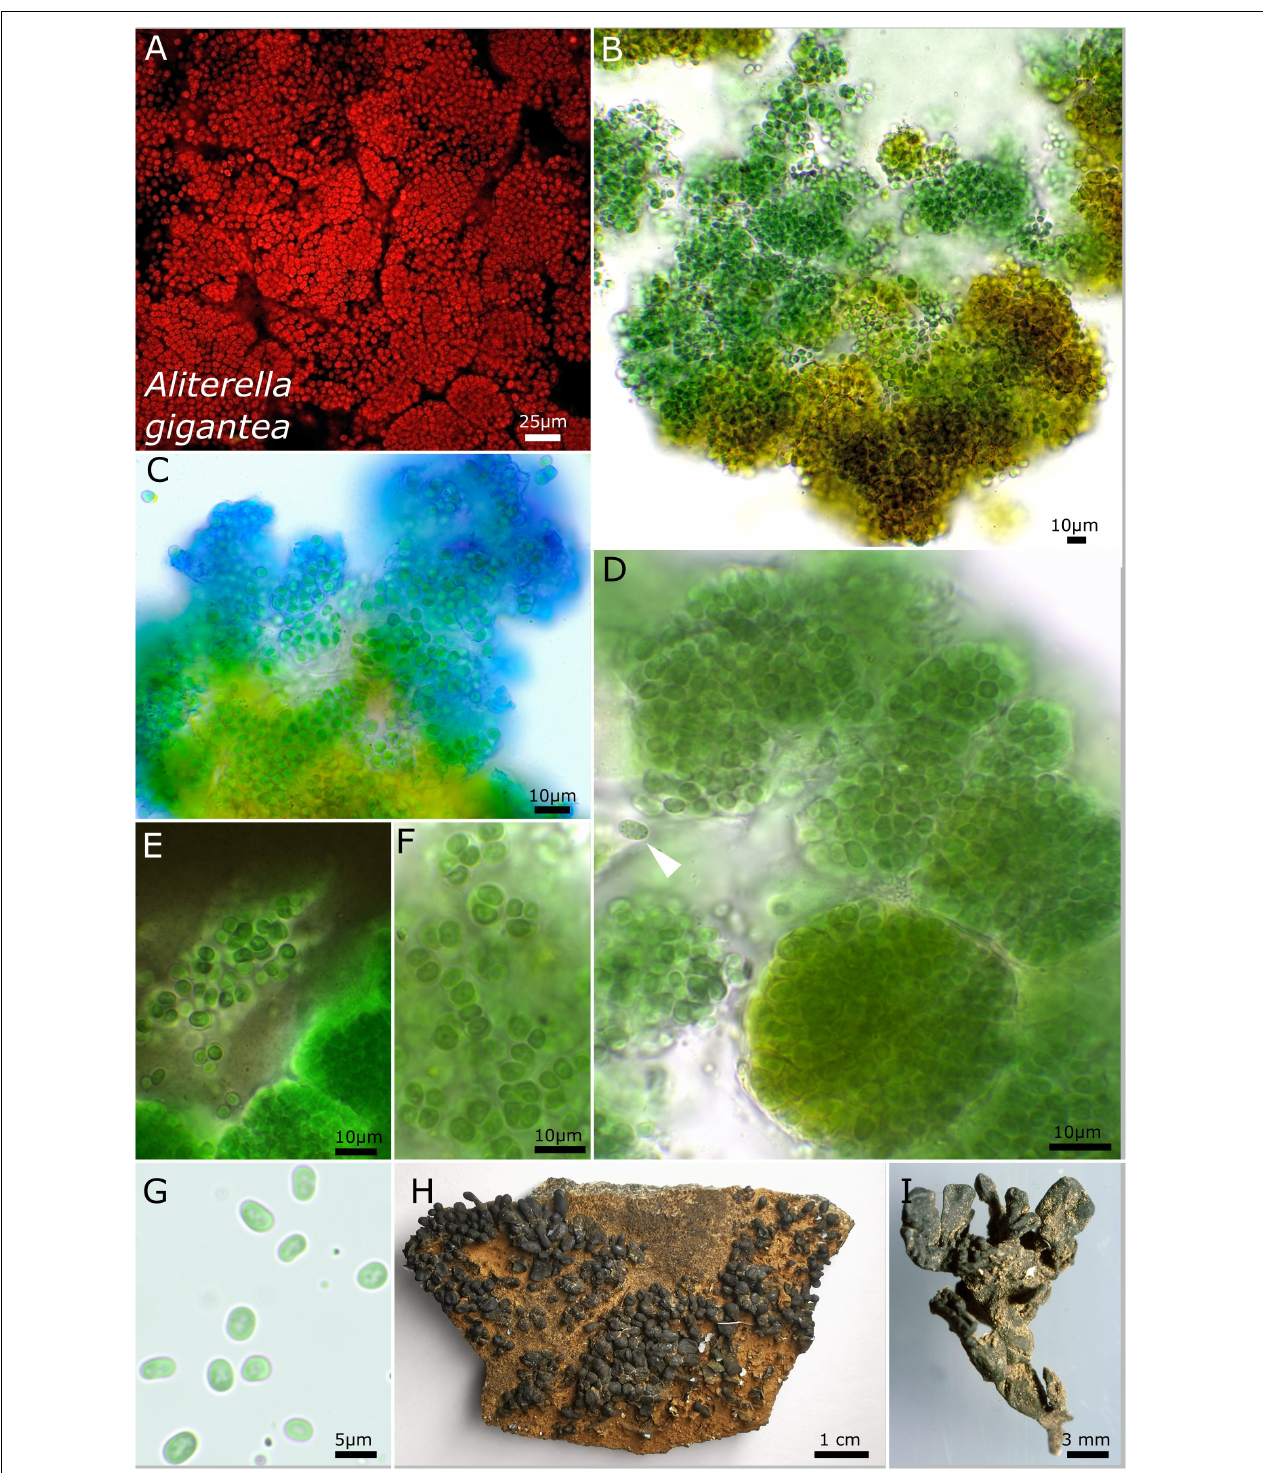
FIGURE 3 | Micrographs showing Aliterella gigantea . (A) Autofluorescence image, (B–G) light microscopy, and (H,I) photographs of the lichen. (B) Yellow color of the peripheral parts of the colony. (C) ACN staining indicating the firm sheath matrix of larger colonies. (D) Package-like colonies made of hundreds of single cells enclosed in firm, hyaline sheaths; the white arrow points toward unsheathed single cell with fine granules at the periphery of the cell. (E) Indian ink staining highlighting the firm sheath of cell packages and unsheathed single cells. (F) Small groups of a few cells with parietal thylakoid membrane. (G) Unsheathed single cells with thylakoid-free lumen in the center of the cells. (H) Overview photograph of Peltula clavata . (I) Close-up photograph of lichen thallus.